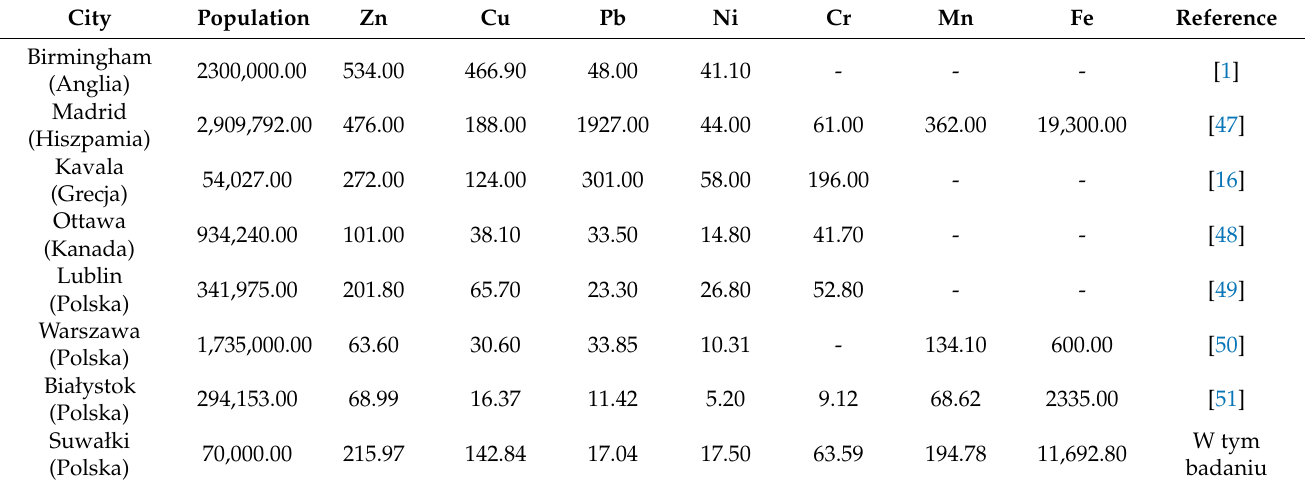
Table 2. Average concentration (mg · kg − 1 ) of metals in road dust from various cities in the